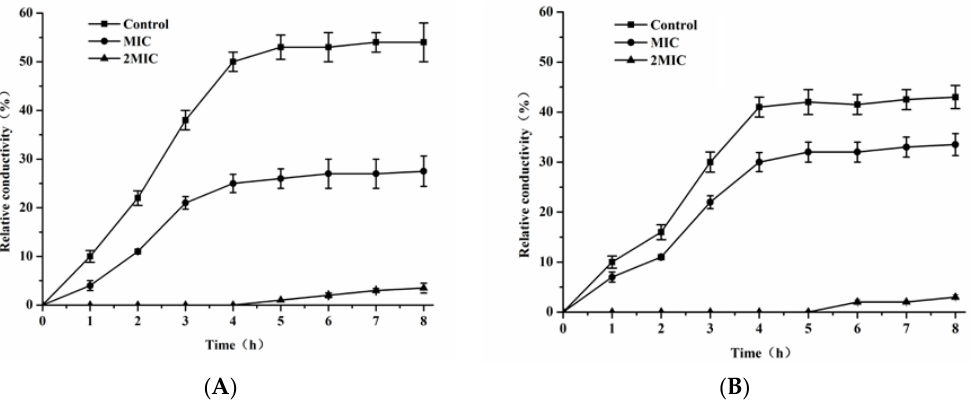
Figure 4. Effect of FEO on cellular leakage of E. coil ( A ) and S. aureus ( B ). The concentrations used corresponded to control, MIC, and 2MIC. Values of each curve are means ± SD ( n = 3).